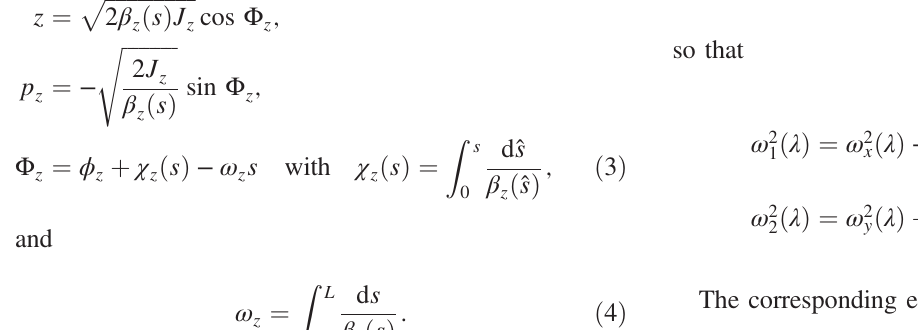
ffiffiffiffiffiffiffiffiffiffiffiffiffiffiffiffiffiffiffiffiffiffiffi p δ 2 λ Þ þ 4 q 2 2 ð